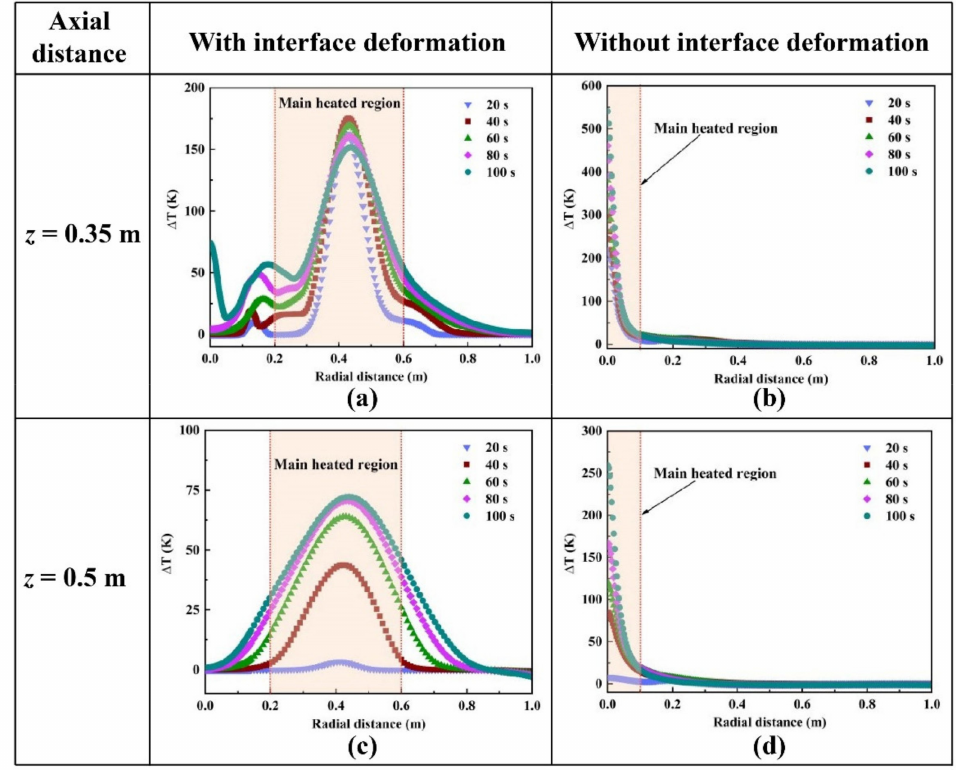
Figure 10. Heating rate of molten bath with an arc current of 10 kA and an arc length of 300 mm: ( a , c ) with interface deformation; ( b , d ) without interface deformation.